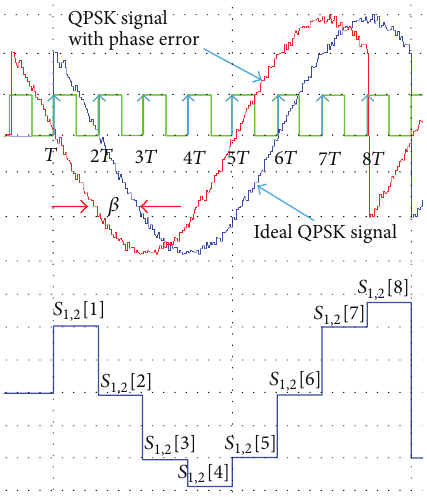
Figure 6: Samples obtained for phase error and standard QPSK signals from 𝑛 = 1 until 𝑛 = 8 . Table 2: Comparison of signal power between the two schemes. Demodulation